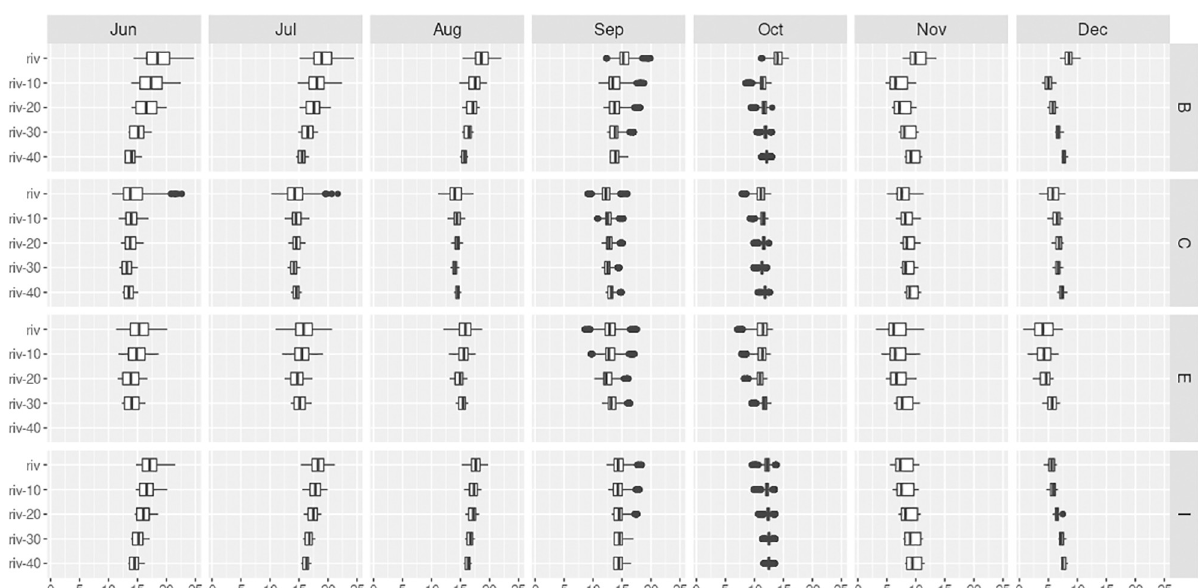
Fig 5. Boxplot of mean hourly temperature along the seasons (from June to December), along the stream (from B to I site) and with depth (blue: Surface water temperature; shades of brown: Hyporheos water temperature).